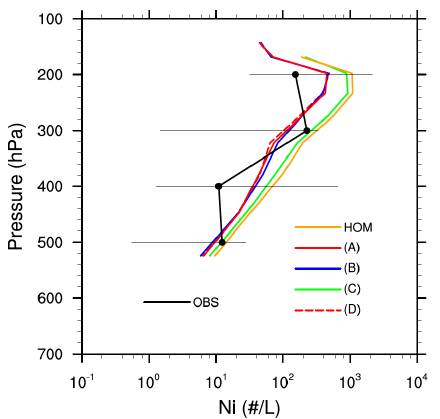
Figure 6. Monthly mean profiles of the simulated in-cloud ice crys- tal number concentrations ( Ni ∼ N ice ) over the ARM SGP site. The four cases shown in the figure include the pure homogeneous ice nucleation case (HOM) and four pure heterogeneous ice nucleation cases: (a) AIDA interpolated; (b) AIDA fit; (c) P13; and (d) AIDA = 105%). Black dots show the observed mean interpolated (RH ∗ i profile of Ni . Left and right ends of the horizontal bars indicate the 10th and 90th percentiles of the observed Ni values at each pressure